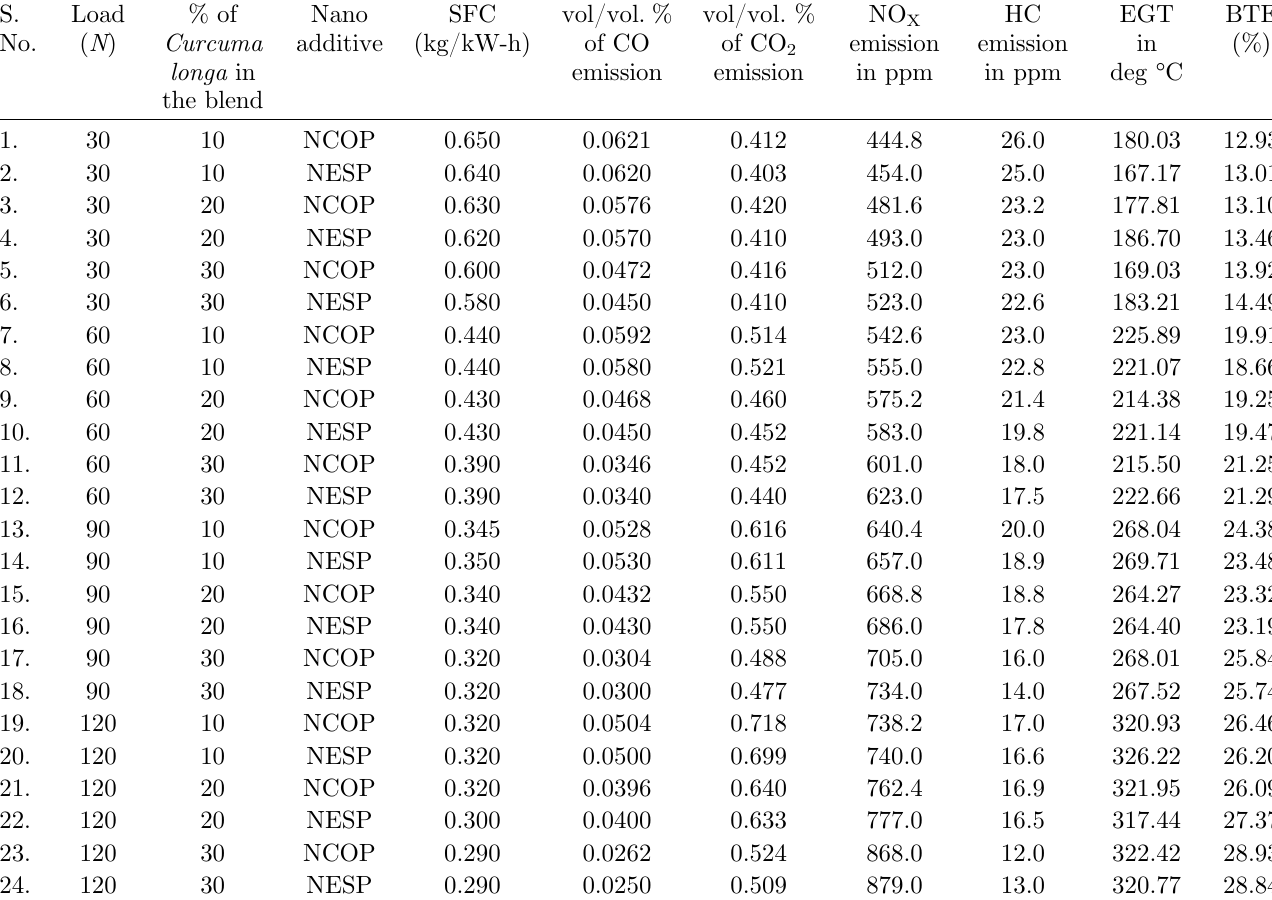
Table 3. Plan of experimentation for the optimization study and the results of output variables.